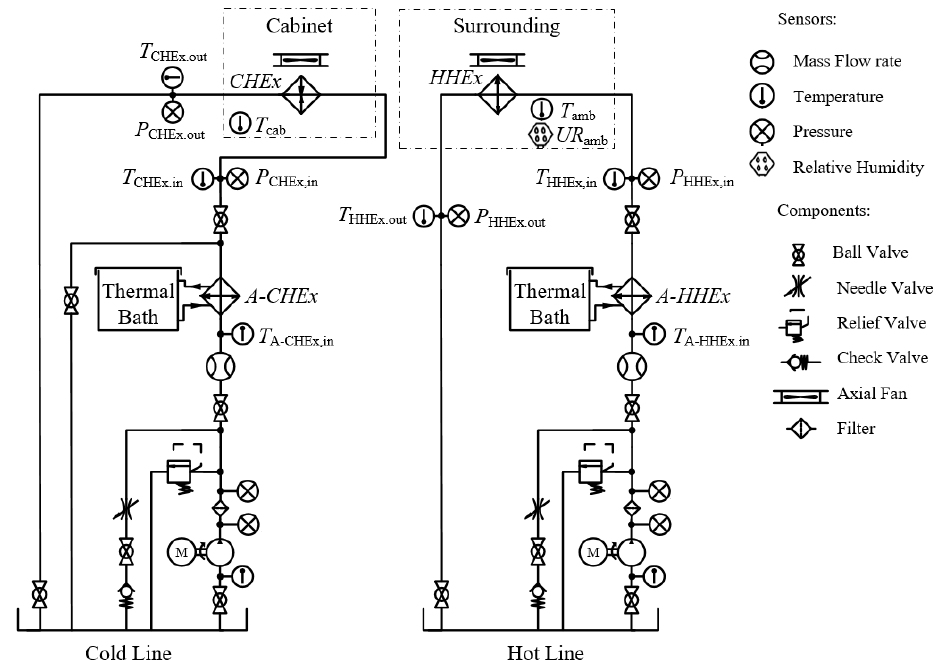
Figure 1. Schematic diagram of the experimental apparatus (AMR emulator).